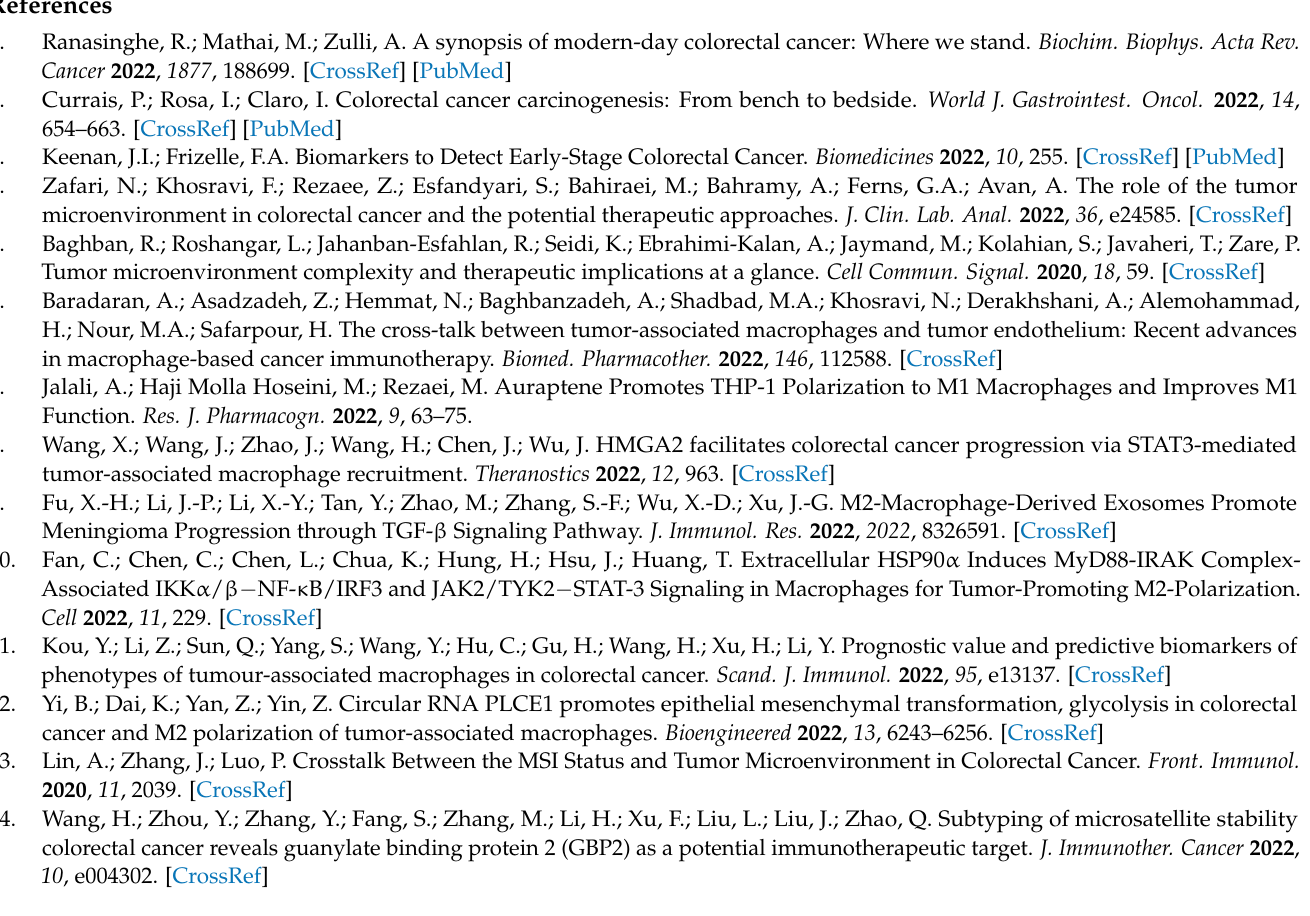
model. Figure. S1: High EMR1 activation in colorectal cancer cells was induced by macrophages. Figure. S2: Toxicity of M2-type macrophage polarization inhibitors (O-ATP, trametinib, Bardoxolone methyl) in colon cancer cells (HCT15, Caco2) and myeloid cells (THP-1